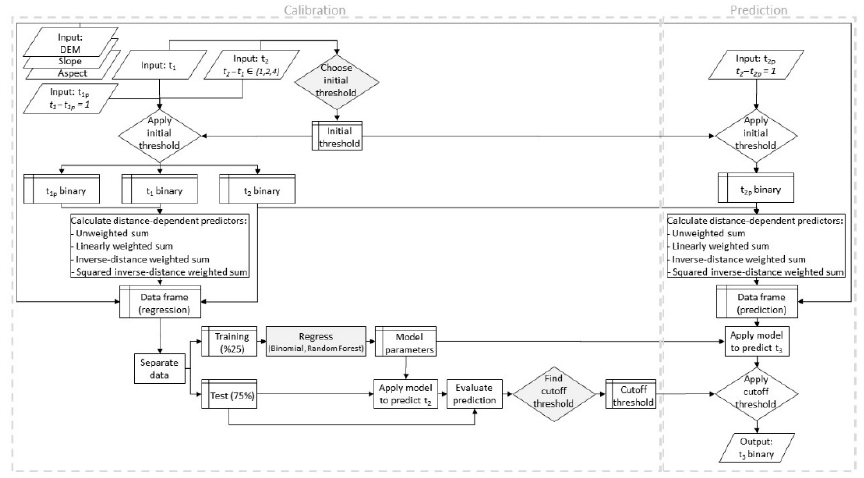
Figure 2. Schematic representation of the integrative approach to parametrize and calibrate our model to simulate forest insect disturbances.